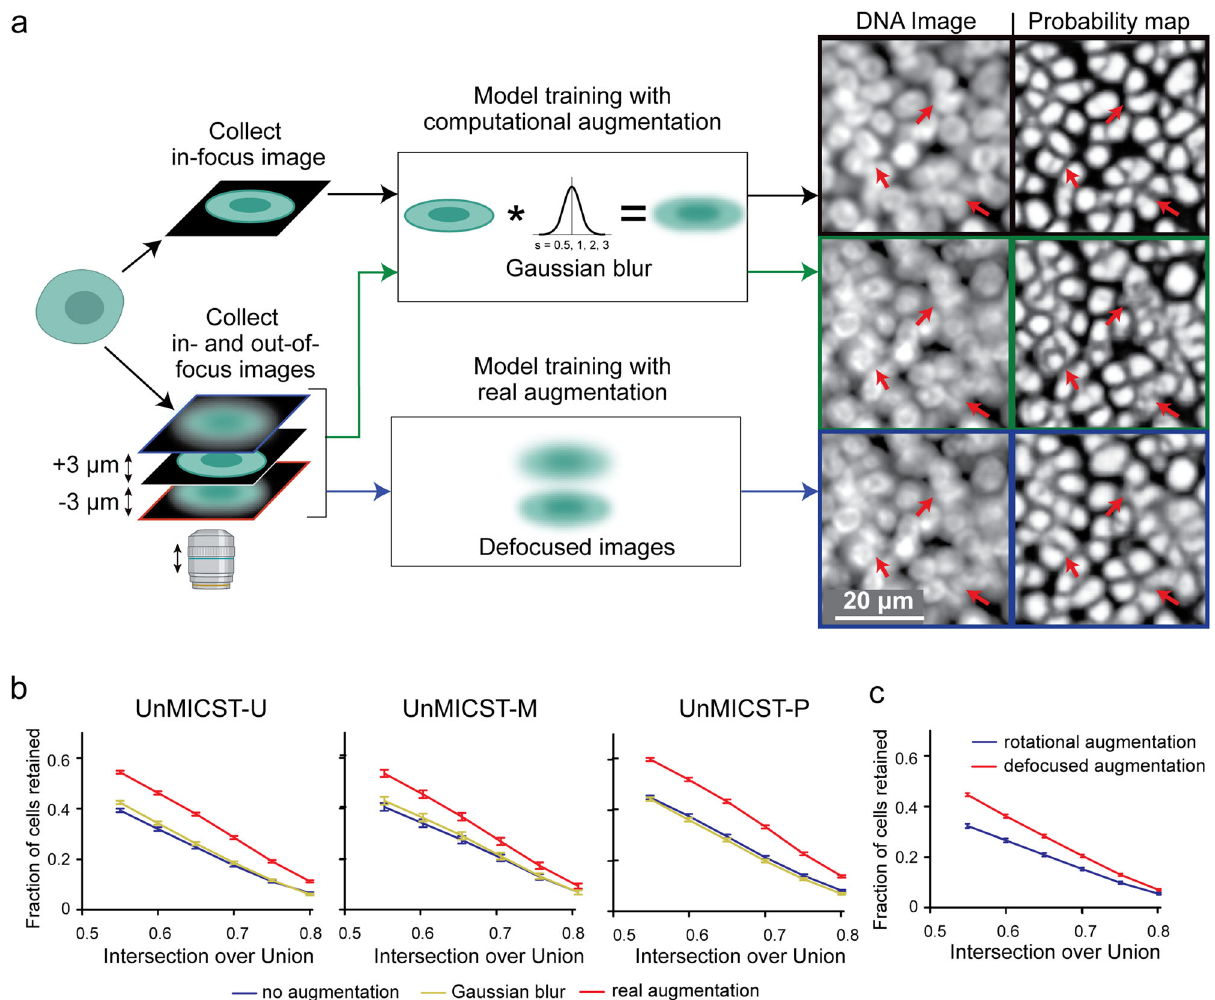
Fig. 1 Comparing the use of real augmentations (defocused and overexposed images) and Gaussian blur. a Schematic diagram showing the approach comparing test images on models trained with Gaussian-blurred or defocused image data. Higher contrast probability maps signify more con fi dence — areas of interest are highlighted with red arrows. Corresponding probability maps indicate a model trained with defocused images performs better on defocused test images than a Gaussian-blurred model. Scale bar denotes 20 μ m. b Plots show that incorporating real augmentations (red curve) into the training set is statistically signi fi cantly superior to training sets with Gaussian blur (yellow curve) and without real augmentations (blue curve) for UnMICST-U, UnMICST-M, and UnMICST-P. Simulating defocused images with Gaussian blur is only marginally better than not augmenting the training data at all. c Comparing UnMICST-U model accuracy when the training dataset size was held constant by replacing defocused augmentations (red curve) with 90 and 180° rotations (blue curve). Error bars are standard error of